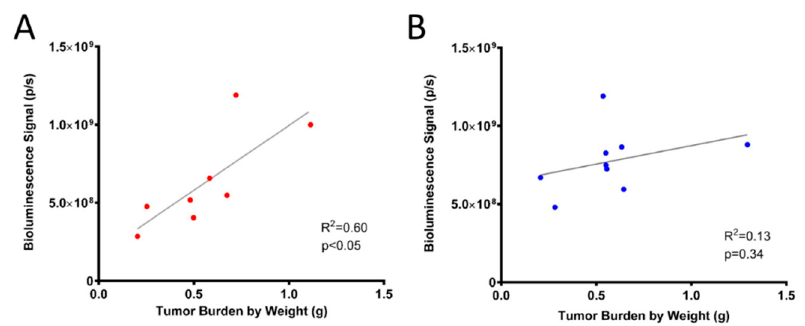
Figure 2. Correlation of bioluminescent signal with tumor weight for ( A ) mice inoculated with 5 million cells ( n = 8) and ( B ) mice inoculated with 10 million cells ( n =9).